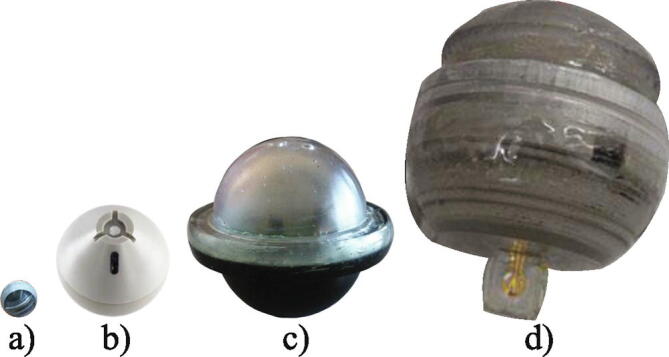
Instrumented sensor devices: a) Sens-o-sphere [58]. b) smartCAPS (pH version) [42]. c) Bio-capsule [43]. d) bPod [44].